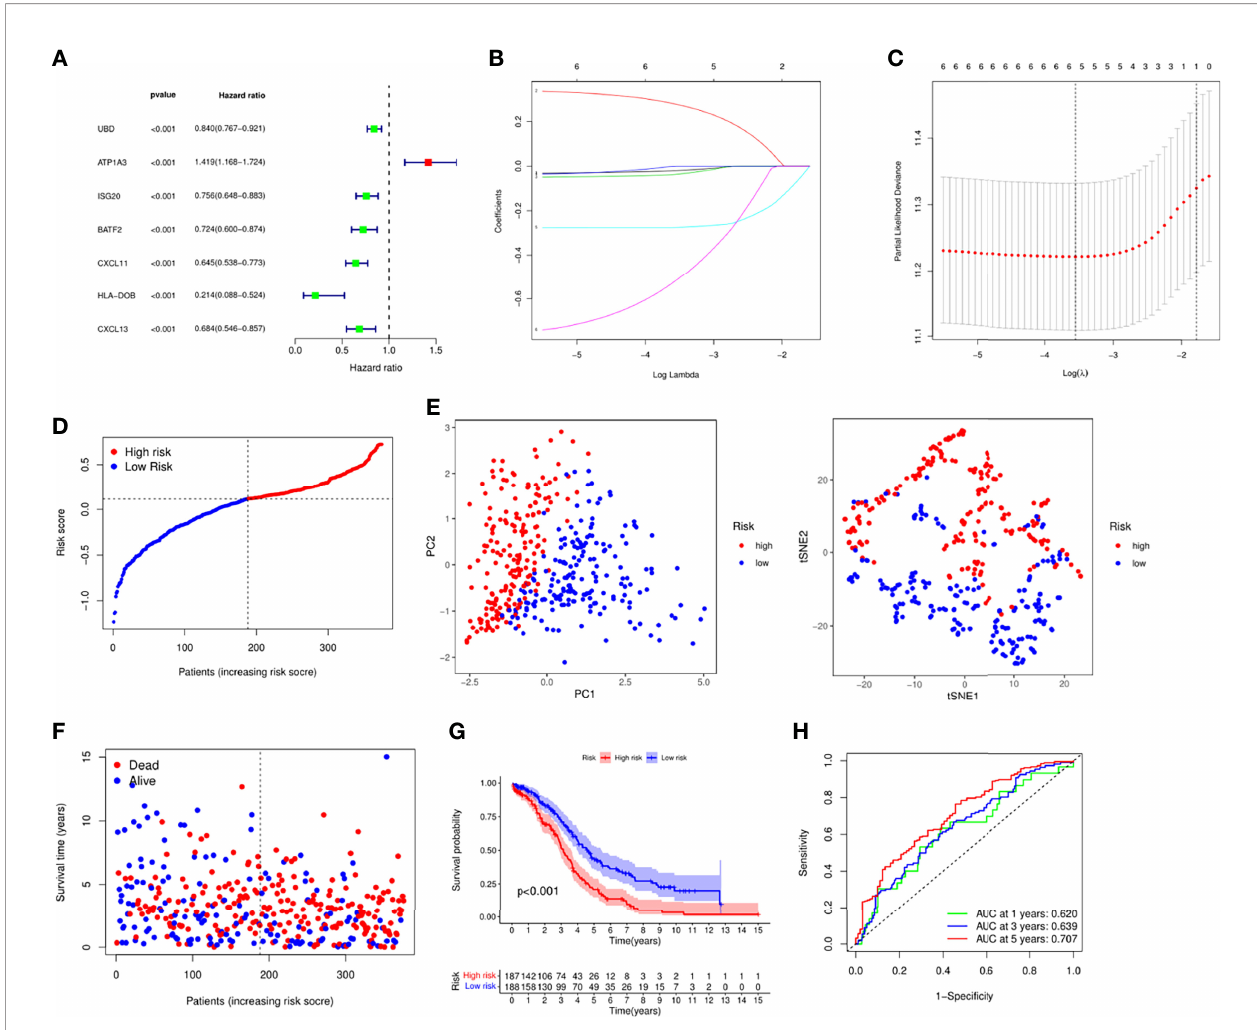
FIGURE 2 | Establishment of risk signature in the TCGA cohort. (A) Univariate cox regression analysis of the necroptosis-related genes. (B) LASSO regression via the prognostic genes. (C) Cross-validation for tuning the parameter selection in the LASSO regression. (D) Distribution of the patients based the risk score. (E) PCA and tSNE analyses classi fi ed patients into two groups. (F) The survival status and risk score of each patient. (G) Survival analysis between high and low risk groups. (H) ROC analysis of the risk